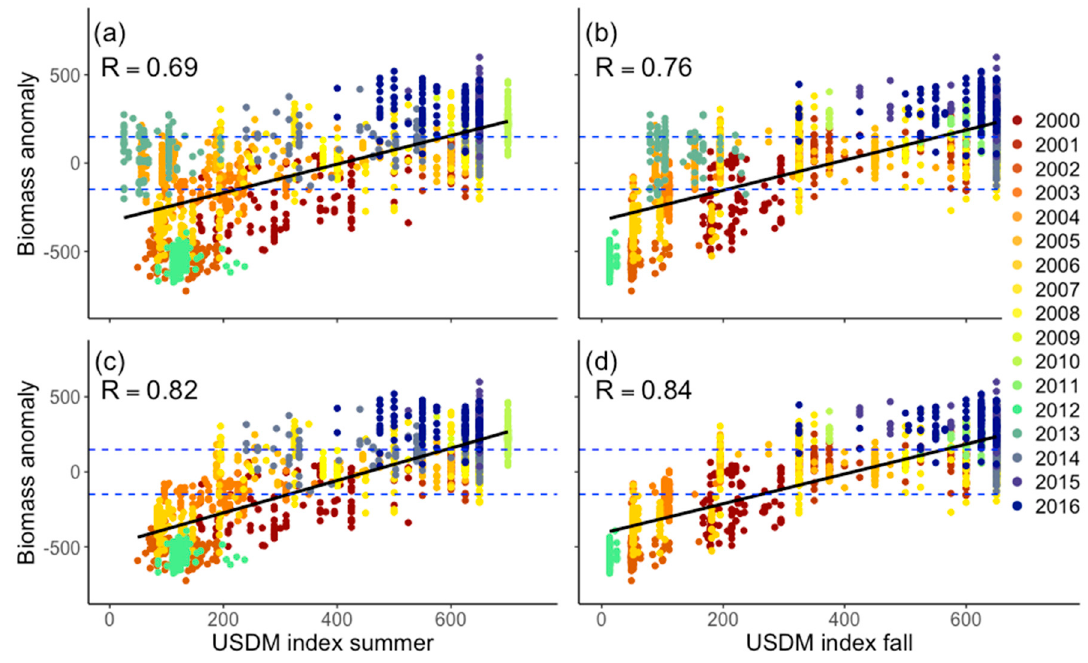
Figure 9. Scatter plots of the interannual biomass deviation and the USDM percentile index. Summer ( a , c ) and fall ( b , d ) were selected as two seasons where USDM percentile index explained the majority of the biomass variation. Upper plots ( a , b ) display all years of the analysis (2000–2016). Bottom plots ( c , d ) display values without two years that were identified as long-term drought (2004 and 2013). Specific years are identified by unique colors. The blue dashed line represents a significant deviation from normal and the black solid line is the regression